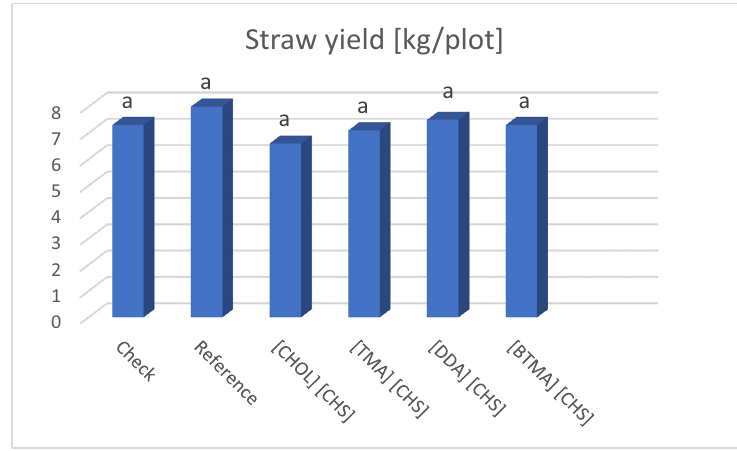
Figure 6: In fl uence of the tested HILs ( 1 – 4 ) on straw yield ( kg/plot ) of fi ber fl